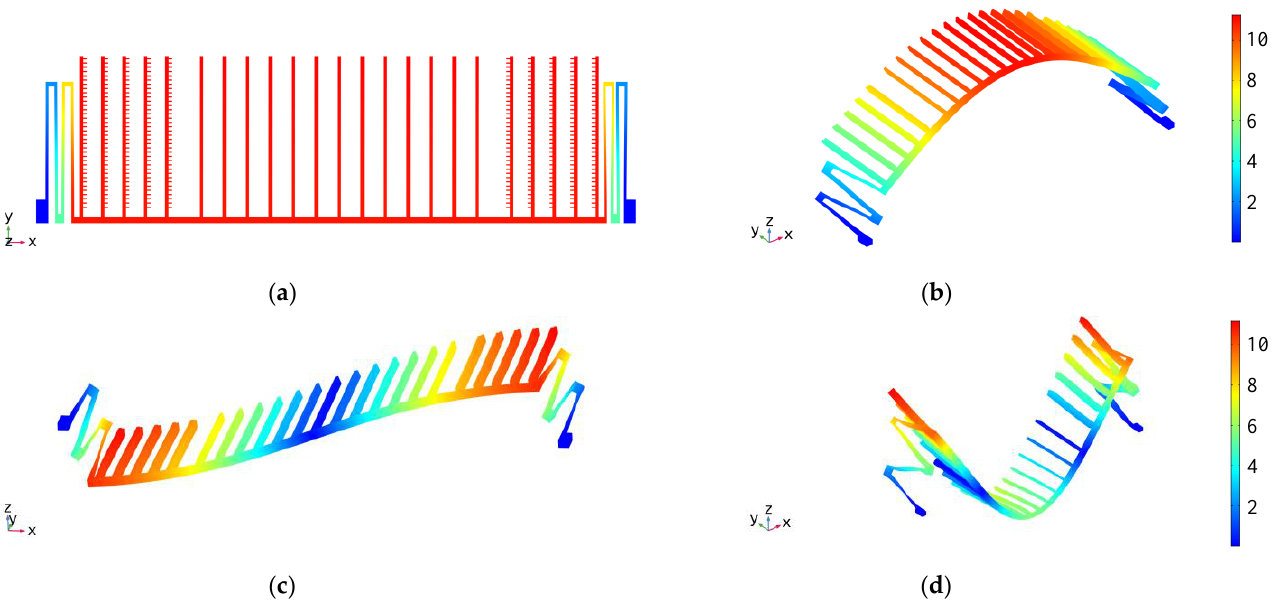
Figure 11. The first four-order eigenmodes deformation diagram of the MEMS microstructure: ( a ) First-order: parallel X-direction vibration mode; ( b ) Second-order: Z-direction vibration mode; ( c ) Third-order: Y-axis as rotation axis, small-amplitude flip and swing in XZ plane; ( d ) Fourth order: the flip vibration mode in the Z direction. The numerical value on the color legend represents the relative value of the mode shape. Table 4. The characteristic frequencies corresponding to the first four modes of the MEMS sensor.